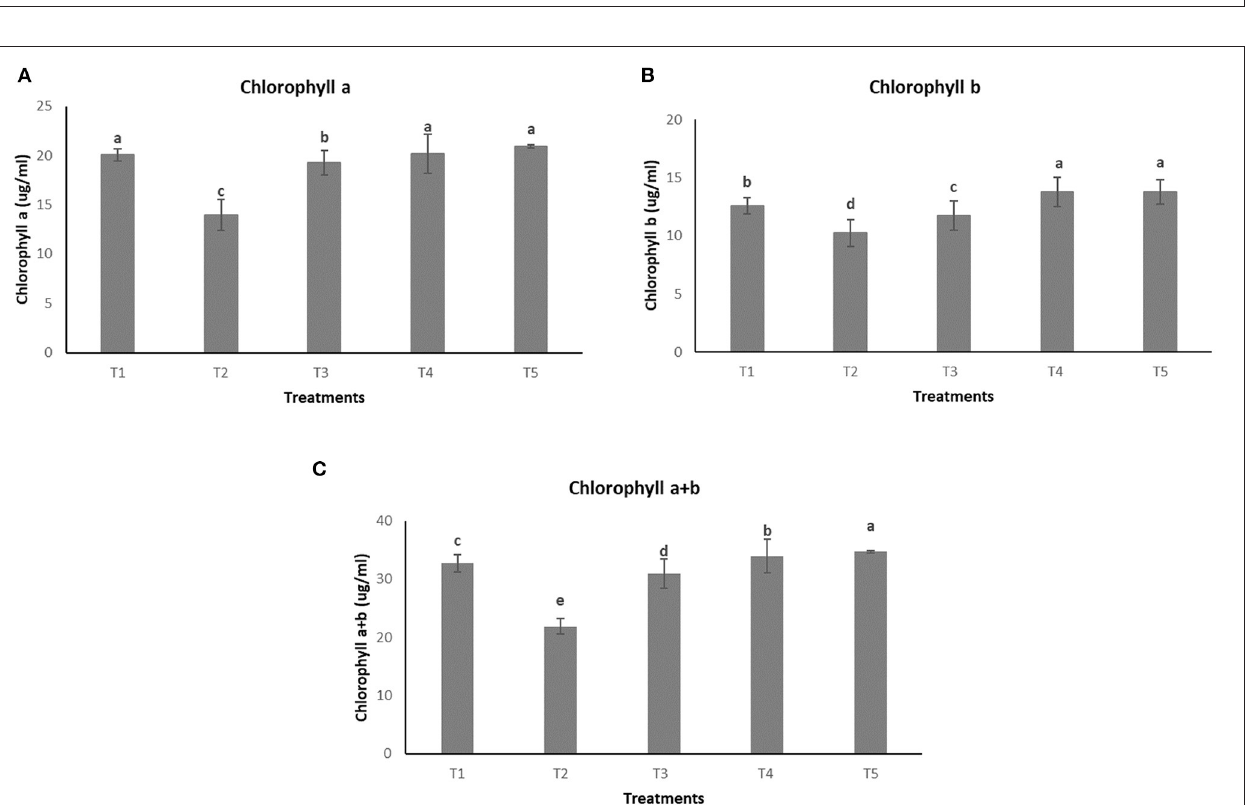
FIGURE 7 | Effect of different treatments on chlorophyll content of plants (A) Chlorophyll a. (B) Chlorophyll b. (C) Total chlorophyll content (a +